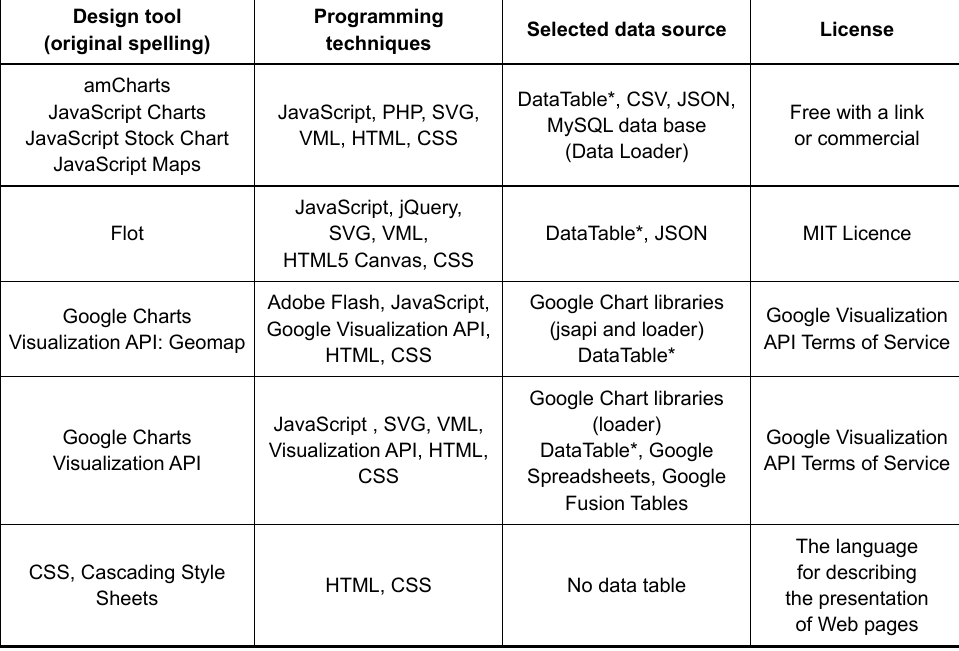
Table 1. Programming techniques and design tools subjected to comparative analysis Design